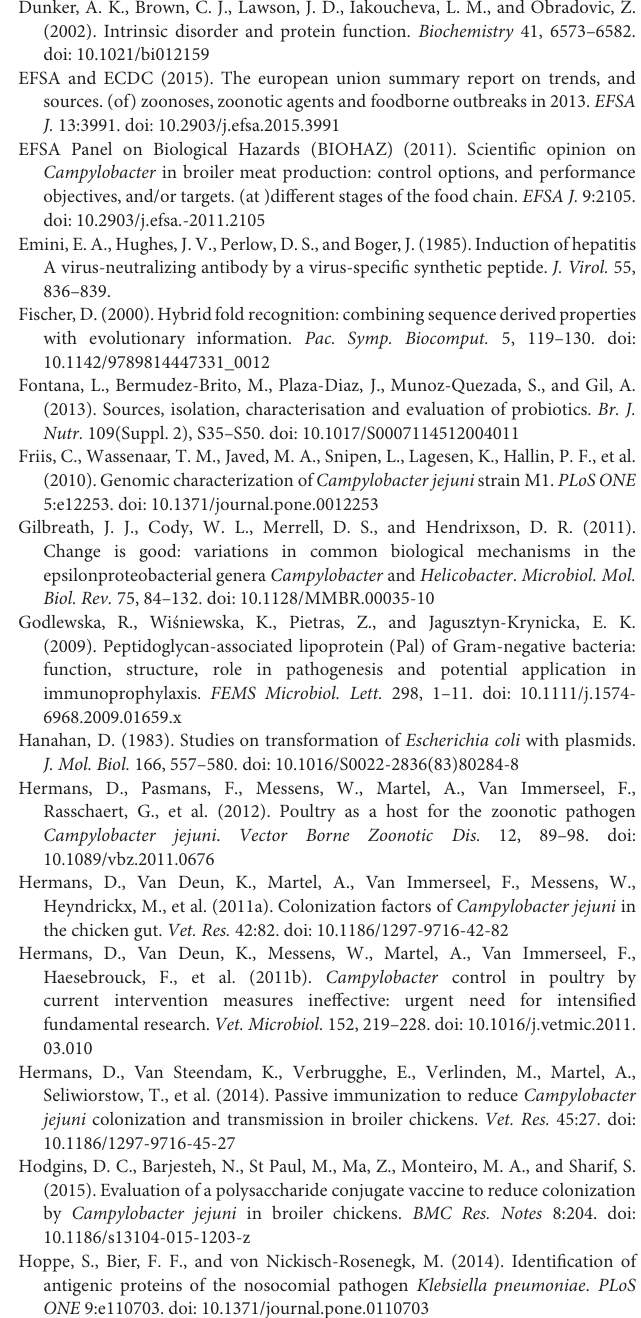
FIGURE S1 | The scheme of pUWM1373 construction. FIGURE S2 | Amino acid sequence of CjaA containing inserted three CjaD peptide epitopes (EVSGV, DEWGTDEYN, GETNPVCTEKTKACDAQNRR) in